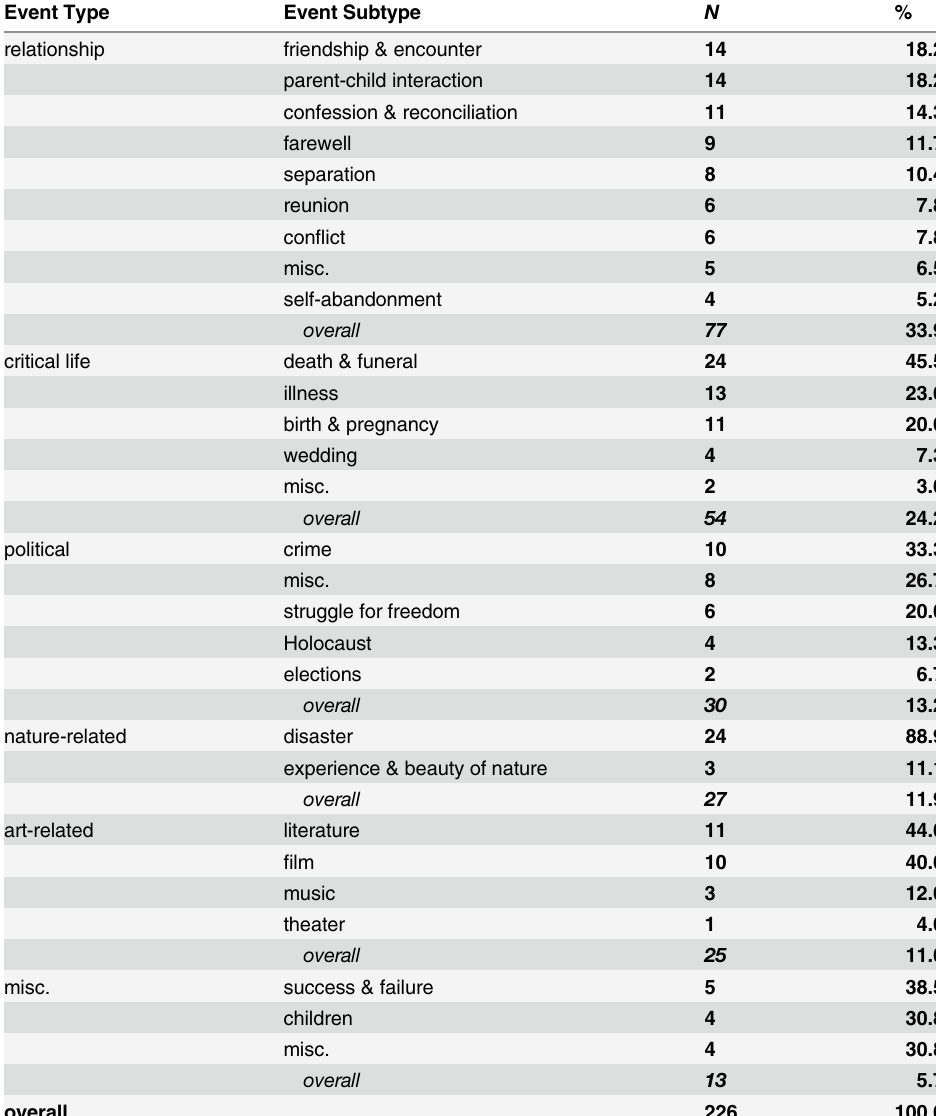
Table 1. Tabulation of event descriptions by event types and subtypes for Study